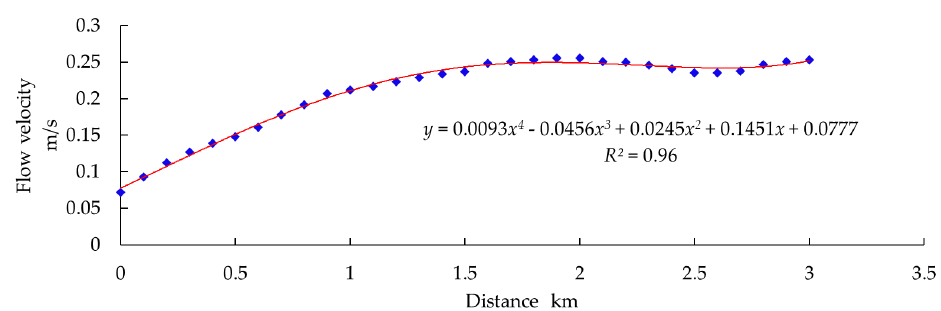
Figure 10. Fitted curve for flow velocities along the Baigou Canal during the wet season (August) as a function of distance from the lake’s inlet.